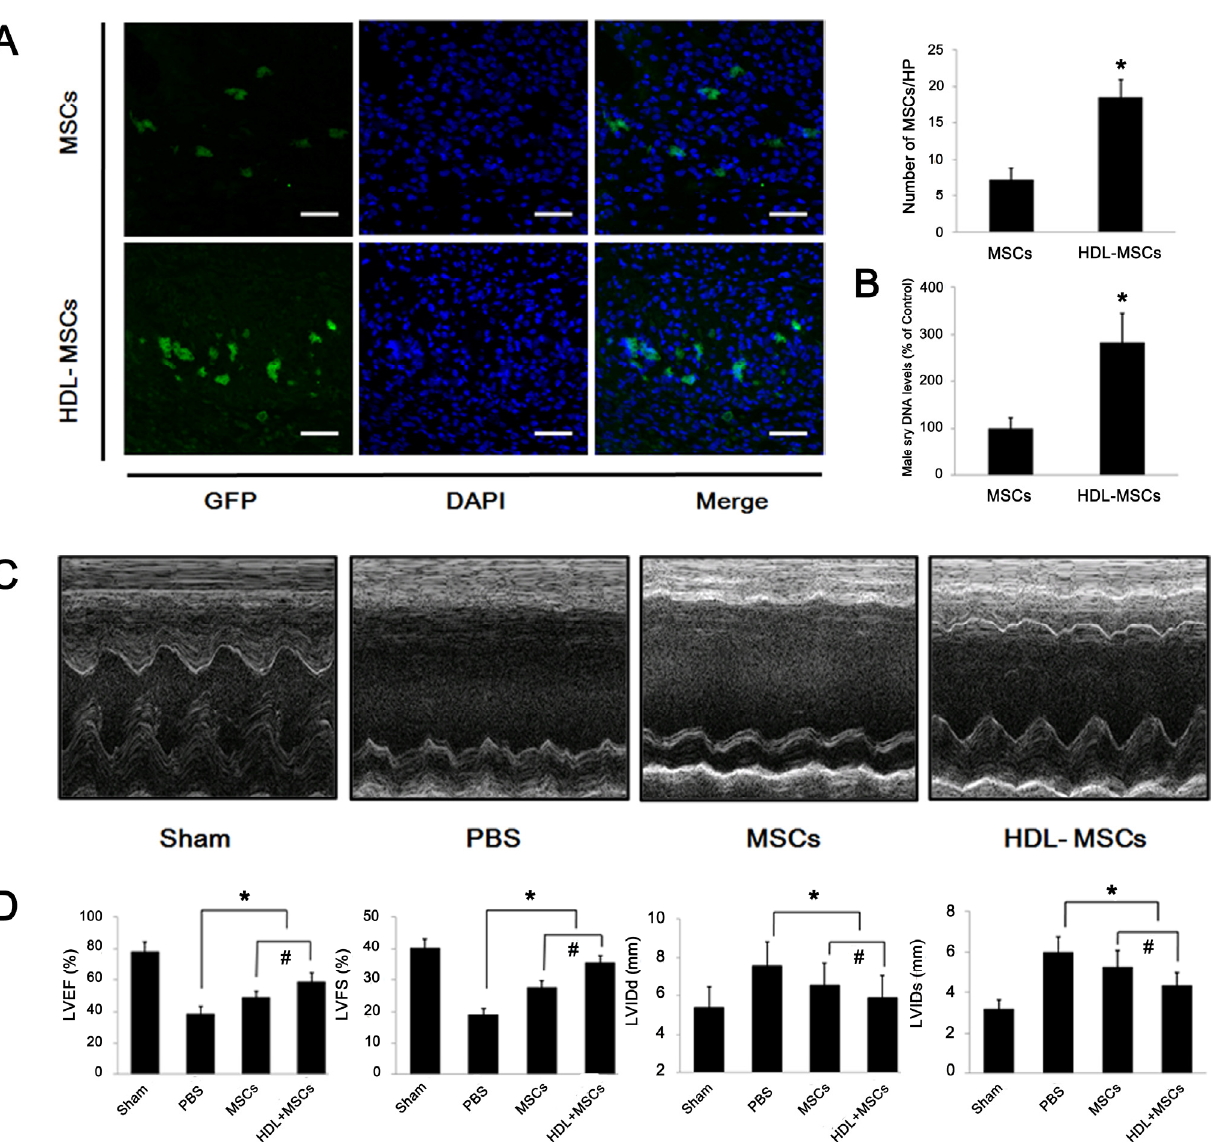
Figure 5. Effects of HDL preconditioning on transplanted MSCs survival and cardiac function in the rats with experimental MI. ( A and B ) The number of GFP + MCSs was counted under fluorescent microscopy four days after injection. Representative photomicrographs ( A , scale bar = 100 μ m) and the corresponding histogram are displayed. Male sry DNA was examined by real-time PCR. n = 7 per group. * p < 0.05 vs.